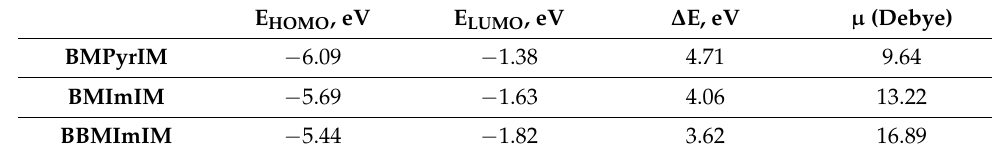
Table 5. The calculated quantum chemical parameters of the examined ionic liquids.